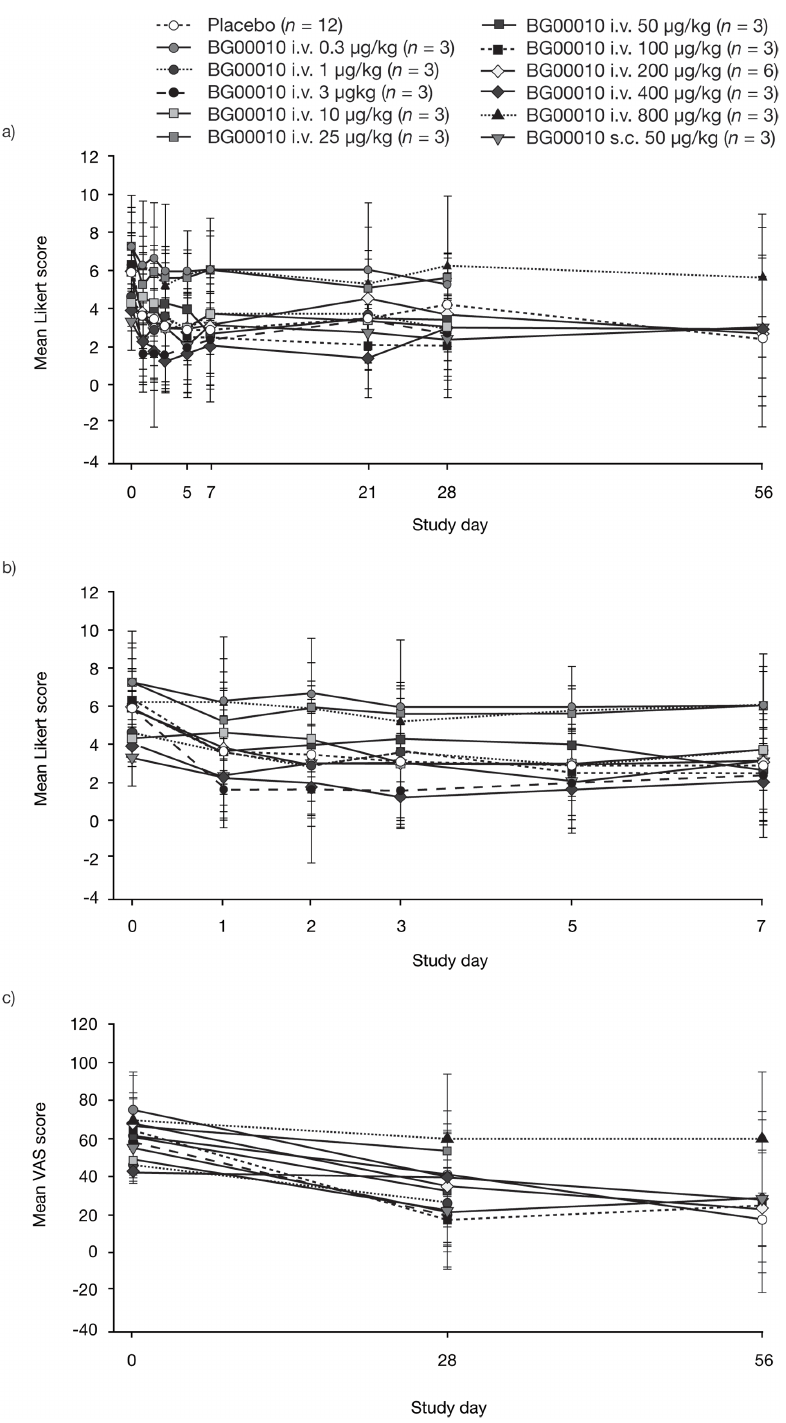
Fig 3. Pain outcomes over time. Mean (standard deviation) scores on the Likert numerical pain scale over (a) 56 days and (b) 7 days (expanded time axis), and (c) mean (standard deviation) scores on the 100 mm VAS of the Short-Form McGill Pain Questionnaire over 56 days, following i.v. or s.c. administration of BG00010 or placebo. Note that Likert data were missing at day 21 for one placebo-treated subject, and both Likert and McGill data were missing at day 56 for six placebo-treated subjects and all subjects treated with BG00010 0.3, 1, 3, 10, 25 or 50 μ g/kg. i.v., intravenous; s.c., subcutaneous; VAS, visual analog scale.